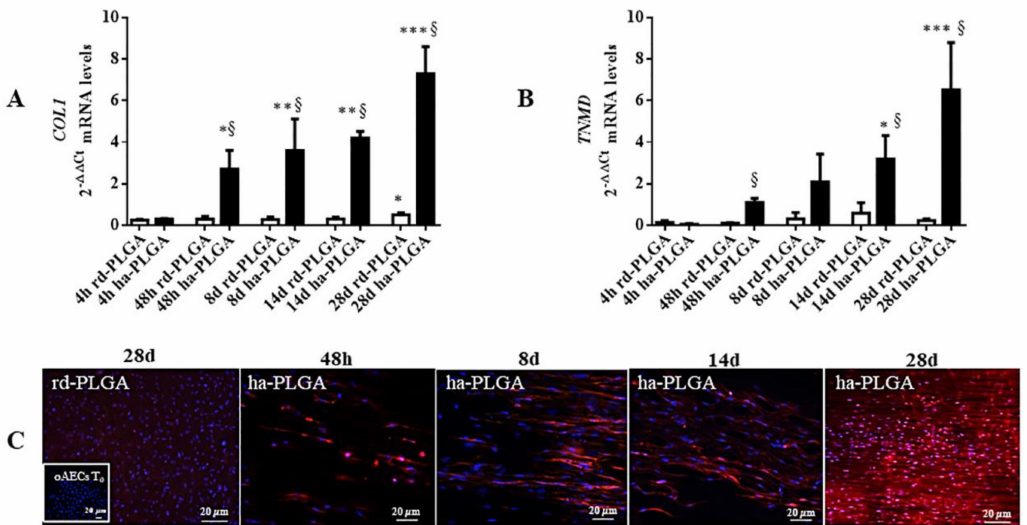
Figure 7. Teno-inductive properties of ha-PLGA electrospun fleeces on AECs. COL1 and TNMD gene expression, and COL1 protein immunopositivity were evaluated at different culture points. Quantitative RT-PCR data show a significantly higher expression in oAECs seeded onto ha-PLGA fleeces of ( A ) COL1 mRNA expression starting from 48 h culture, whereas ( B ) TNMD mRNA expression started to be upregulated after 14 days culture. COL1 and TNMD gene expression were always lowly expressed in rd-PLGA at all culture time points. * p < 0.01 different values in the same fleece type. ** p < 0.001 different values in the same fleece type. *** p < 0.0001 different values in the same fleece type. § p < 0.01 different values between different fleeces in each time. ( C ) IHC analysis revealed COL1 protein expression (red fluorescence) in oAECs when seeded onto ha-PLGA and rd-PLGA; whereas freshly isolated cells do not express the protein (inset). Nuclei were counterstained with DAPI (blue fluorescence). Images show that cells seeded onto rd-PLGA never express COL1, whereas it is expressed in AECs cultured on ha-PLGA fleeces already after 48 h culture. Up to 14-day positivity to COL1 was evident in the cytoplasm, whereas at day 28 positivity to the protein was localized also within the fleece. Scale bars = 20 µ m. (n = 3 for each type of sample / analysis / time point, scaffold size: 15 mm × 7